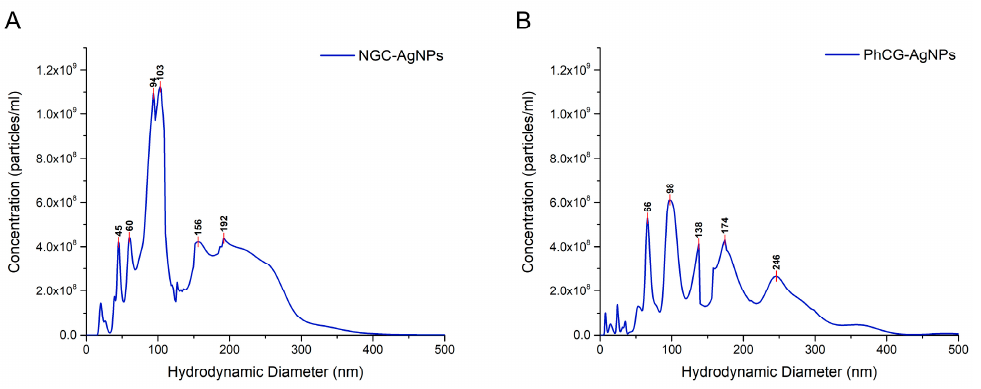
Figure 4. Quantitative particle size analysis by nanoparticle tracking analysis (NTA). Merged results for samples ( A ) NCG-AgNPs (Mean: 119.7 ± 5.1 nm and Mode: 86.4 ± 4.7 nm, 6.36 × 10 10 particles·mL − 1 ) and ( B ) PhCG-AgNPs (Mean: 123.8 ± 8.9 nm and Mode: 103.1 ± 18.8 nm, 4.03 × 10 10 particles·mL − 1 )